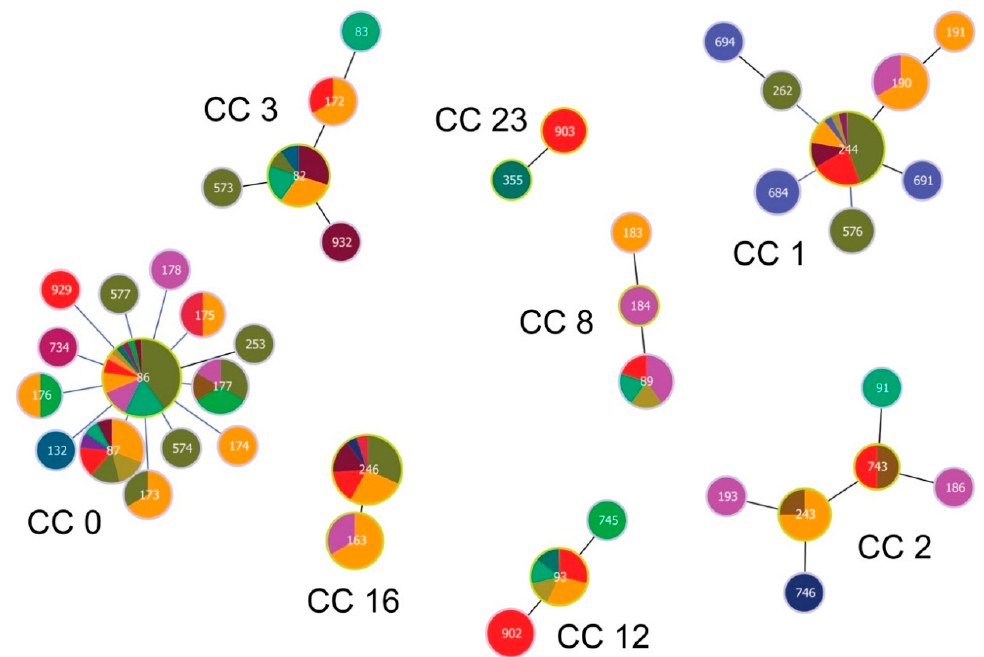
Figure 4. Population structure of Borrelia garinii multi-locus sequence types (STs) involving STs from Slovakia. Population structure for 147 STs deposited in the PubMLST database was constructed by the goeBURST algorithm with PhyloViz 2. Clonal complexes (CCs) were constructed at the level of single-locus variants (SLVs). ST 903 was not assigned into any CC and was classified as a singleton. ST nodes representing inferred CC founders are outlined in light-green color. Node size reflects the number of isolates for the ST. Black lines between nodes refer to links drawn without recourse to tiebreak rules, whereas blue lines show links based on tiebreak rule 1 (number of SLVs). Different colors and their areas within nodes reflect country and the number of isolates for the given ST and country. Red color denotes Slovakia; for country legend please see Figure 5.